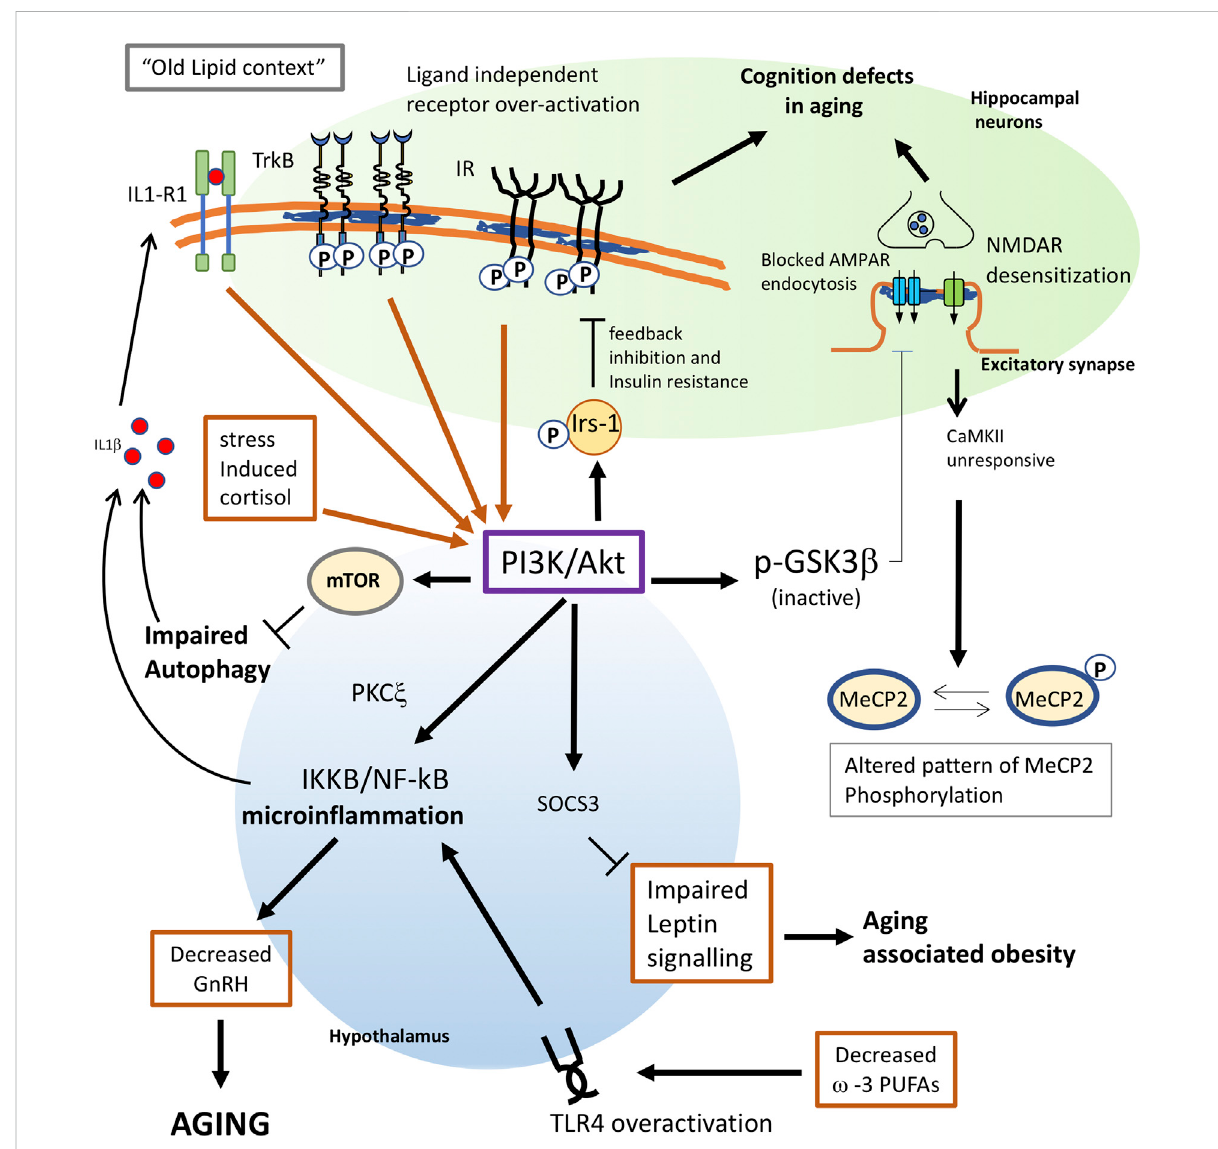
FIGURE 1 Proposed mechanisms for membrane triggered aging in neurons and hypothalamus. Changes in lipid composition give raise to an “ old membrane ” . In hippocampal neurons, this old lipid context favors receptor subunit interaction and ligand independent activation of TrkB and Insulin receptors. Constitutive activation of these receptors greatly increases the activity of the PI3K/Akt pathway. Enhanced PI3K will have multiple consequences in old cells: 1) phosphorylation of IRS-1 favors a feedback inhibition of IR signaling, leading to insulin resistance. 2) In neuronal cells, insulin resistance also leads to impaired insulin-triggered memory formation. 3) Akt inhibits GSK3b activity and impairs the AMPA receptor endocytosis required for proper synaptic plasticity. 4) Overactivation of mTOR by PI3K leads to impaired autophagy which, in old individuals, contributes to trigger in fl ammation and aging. 5) Increased PI3K in the hypothalamus appears to activate NF-kB, leading to microin fl ammation and decreased secretion of gonadotrophin releasing hormone (GnRH), which is a main determinant for aging. 6) decreased ω -3 PUFAs in old cells or impaired function of Gprotein-coupled receptor GPR120 would both contribute to trigger proin fl ammatorysignals through overactivation of TLR4. 7) Enhanced PI3K activity in the hypothalamus may impair leptin signaling via Socs3, leading to aging-associated obesity. 8) Stress-induced levels of cortisol would increase AKT signalling. 9) The in fl ammatory context reached by PI3K overactivation will result in the synthesis of proin fl ammatory cytokines as IL1 β , which further contributes to activate PI3K as part of a positive pro-aging loop. 10) Impaired response of the NMDAR-CaMKII pathway due to lipid alterations will alter the pattern of MeCP2 phosphorylation in old neurons leading to changes in the genome